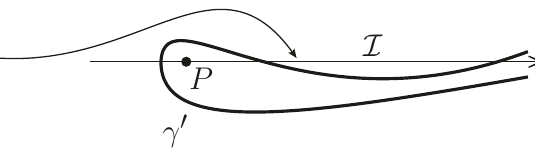
Figure 17 . Average continuation combined with the domain